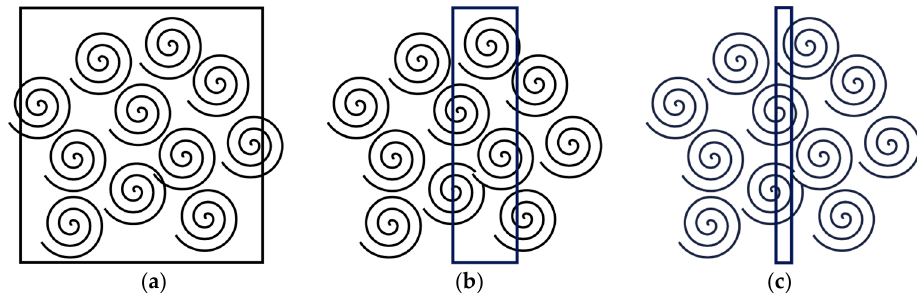
Figure 7. Illustrative sketch of differently used cell sizes. ( a ) cell size >> scrap parts, ( b ) cell size ≈ scrap parts, ( c ) cell size << scrap parts.